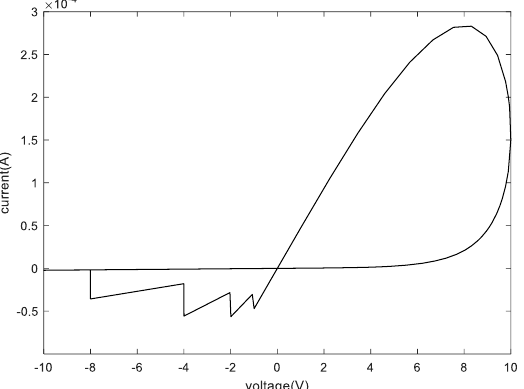
Figure 8. The relationship between voltage and current of the memory cell.